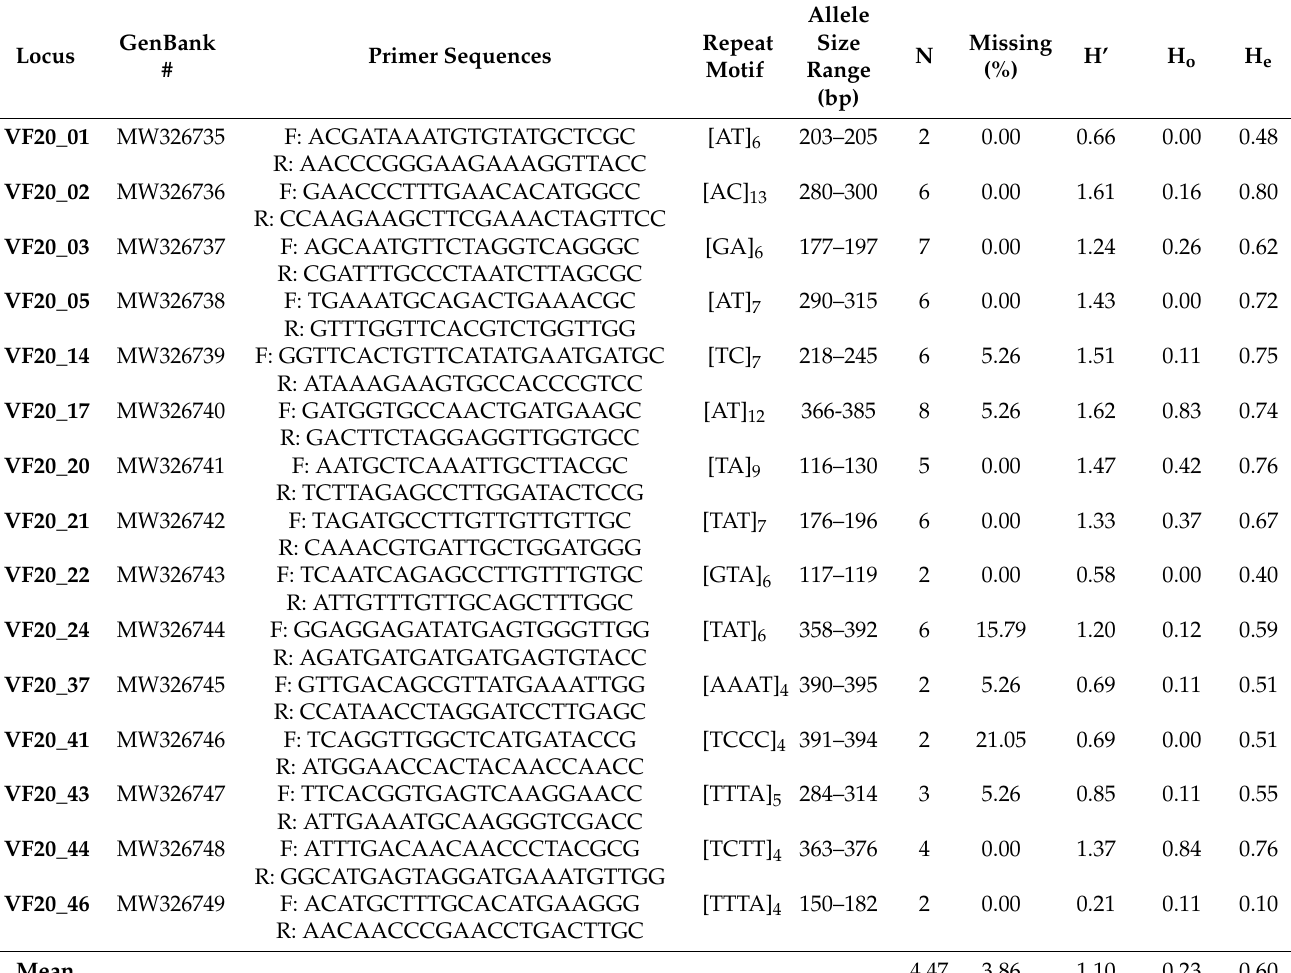
Table 1. Characteristics of 15 gSSR loci developed from Viburnum farreri.